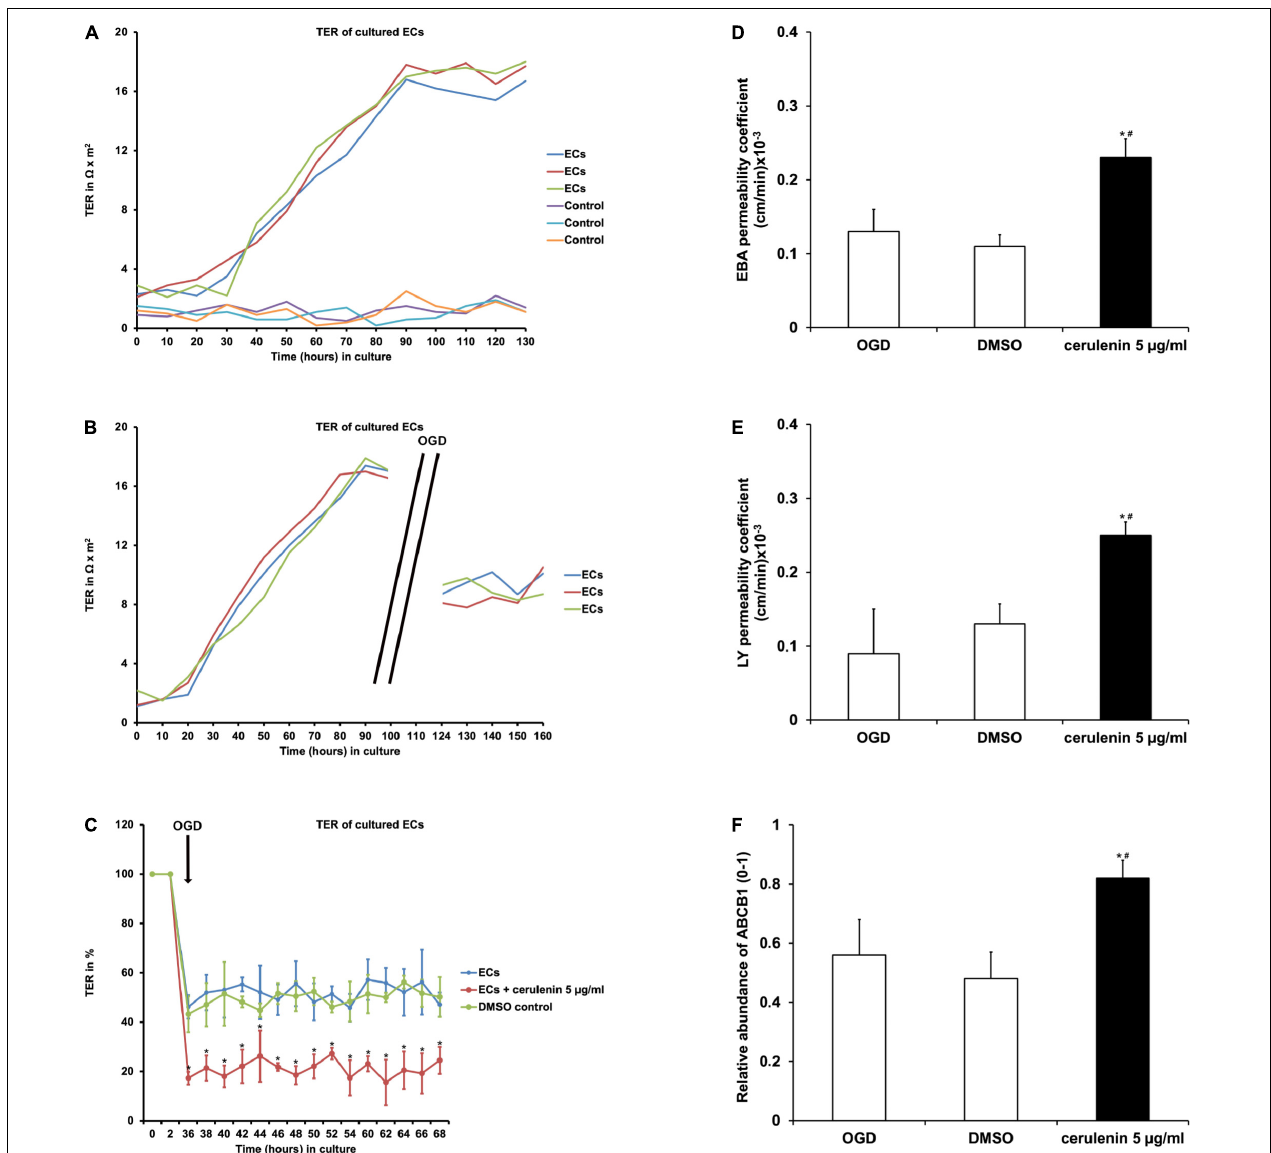
FIGURE 2 | Inhibition of FAS diminishes blood-brain barrier (BBB) integrity and increases the abundance of the ABCB1 transporter in primary endothelial cells. (A) Representative graphs depicting the extent of transcellular electrical resistance (TER) in primary endothelial cells (ECs) under standard cell culture conditions. Empty wells, i.e., wells containing no cells at all are referred to as “control,” indicating background noise of the measurement. (B) Representative graphs for TER measurement in ECs exposed to oxygen-glucose-deprivation (OGD) injury followed by reoxygenation at standard cell culture conditions. Note that TER measurement was not possible during the OGD period itself due to technical limitations. (C) Measurement of TER in primary ECs exposed to OGD ( n = 4). Some cells were treated with cerulenin, whereas DMSO served as control. Pre-OGD values were set as 100%. (D,E) Using a BBB co-culture model existing of both astrocytes and primary endothelial cells ( n = 4 per condition), permeability coefficients for both Evans blue albumin (EBA; large molecule) and luciferase yellow (LY; small molecule) after OGD exposure were performed ( n = 4 per condition). Administration of cerulenin significantly increases permeability coefficients in endothelial cells under hypoxic conditions when compared to DMSO controls. In line with this, protein abundance of ABCB1 is significantly increased when fatty acid synthase is blocked by cerulenin in endothelial cells (F) . *Significantly different from DMSO control, p < 0.05. # Significantly different from OGD samples, p <